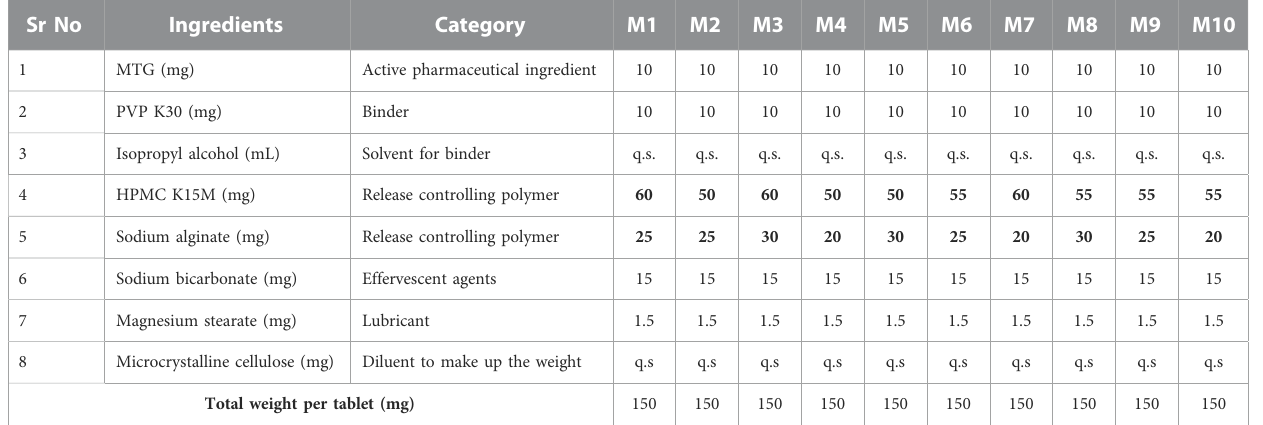
TABLE 1 Composition of MTG fl oating tablets prepared by applying 3 2 full factorial design. Sr